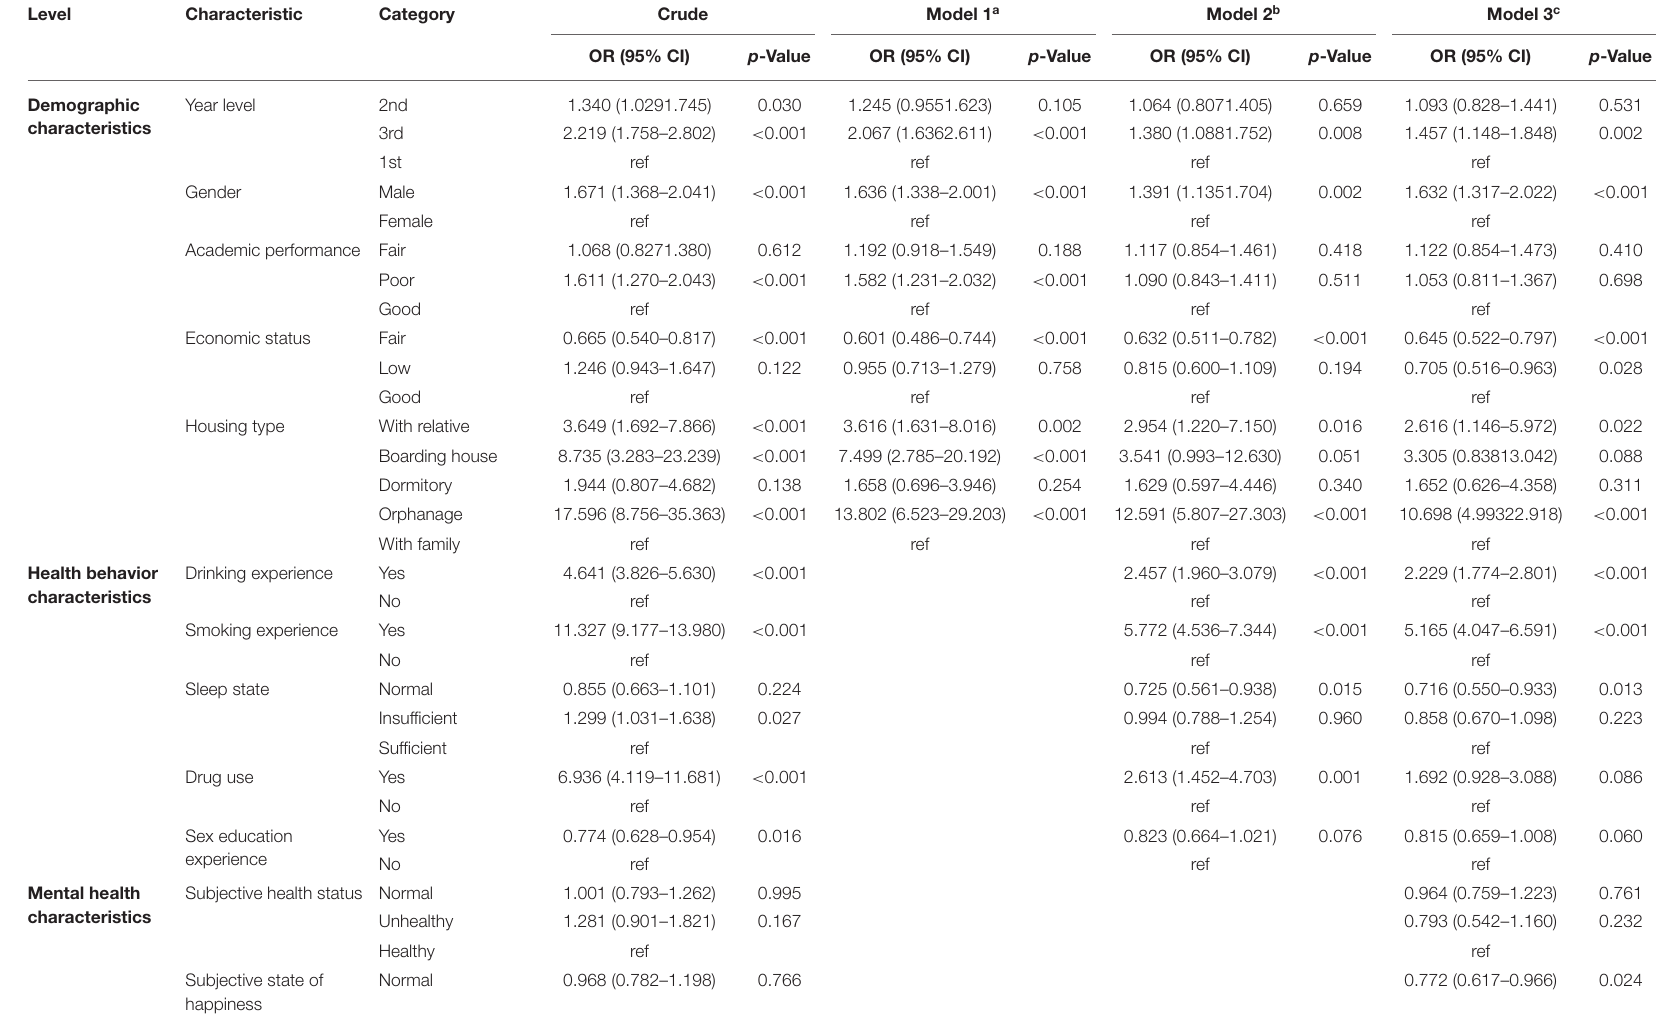
TABLE 4 | Factors affecting sexual intercourse in middle school students ( n =